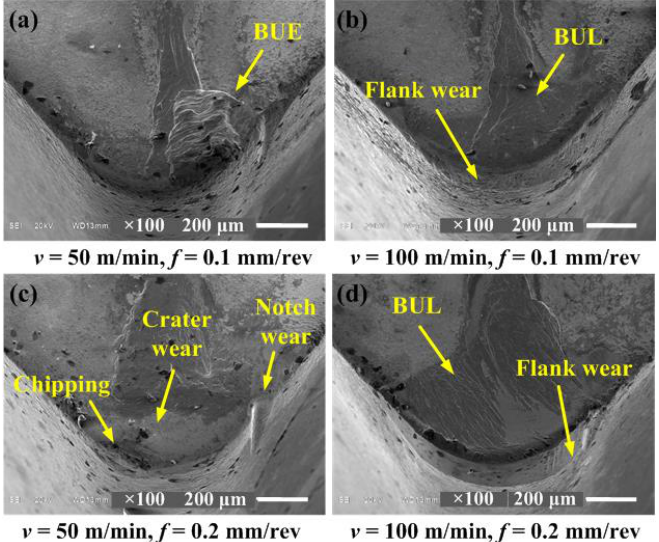
Figure 2. Tool wear patterns in cylinder turning, ( a ) v = 50 m / min, f = 0.1 mm / rev; ( b ) v = 100 m / min, f = 0.1 mm / rev; ( c ) v = 50 m / min, f = 0.2 mm / rev; ( d ) v = 100 m / min, f = 0.2 mm / rev.